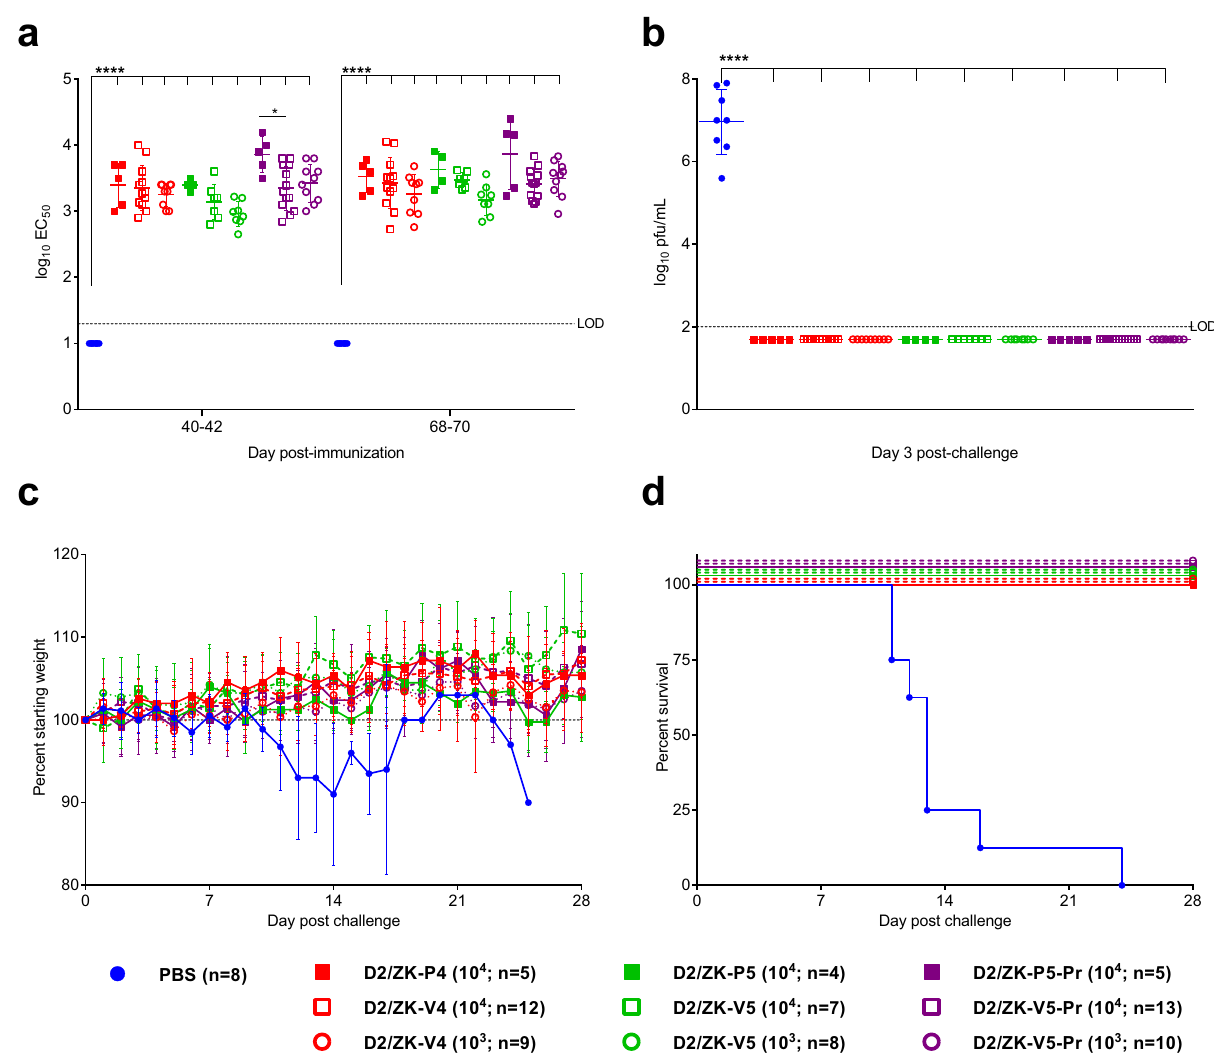
Fig. 7 Single dose of D2/ZK LAV candidates protect AG129 mice from lethal ZIKV challenge. D2/ZK-V candidates were tested at 2 single-dose levels, 10 3 and 10 4 pfu. Their parental chimeric control viruses, D2/ZK-P, were tested at 10 4 pfu dose only. The naïve group received PBS. All mice were challenged with 10 4 pfu of wt ZIKV on day 70. a NAb titers of mice at 40 – 42 days and 68 – 70 days after the single immunization. b Viremia after wt ZIKV challenge. All immunized animals were protected from viremia. c Weight changes after ZIKV challenge. d Kaplan – Meyer survival curves after wt ZIKV challenge. Horizontal bars (in a and b ) represent the group GMT, error bars represent standard deviation. Negative samples are plotted at the half value of the assay LOD and have been included in determination of GMTs and statistical comparisons (one-way ANOVA with Tukey ’ s test to correct multiple comparisons). * p = 0.186, **** p < 0.0001. Number ( n ) of mice used in each group is indicated in the symbol legend. With exception of the D2/ZKV-V5-Pr group showing signi fi cantly lower NAb titers than its P counterpart group on day 40 – 42, no signi fi cant differences were observed between groups that received D2/ZK-V and -P